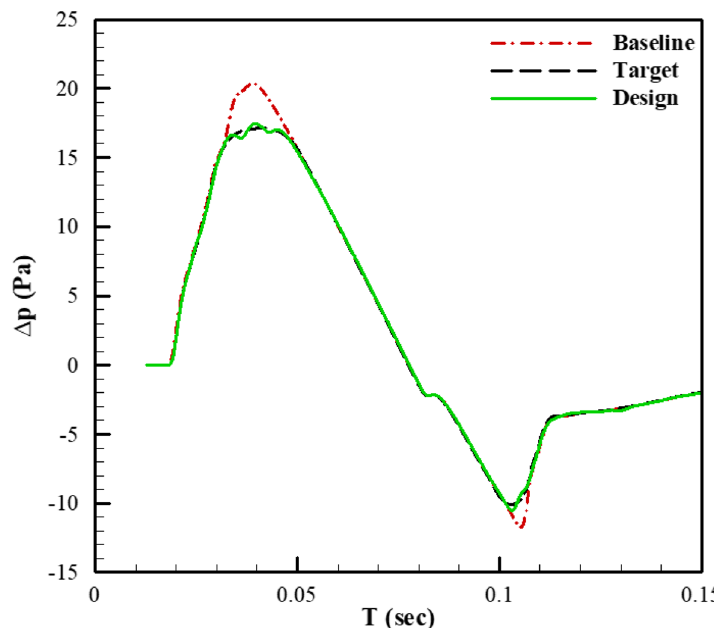
Fig. 16 Comparison of optimized ground signature and target signature